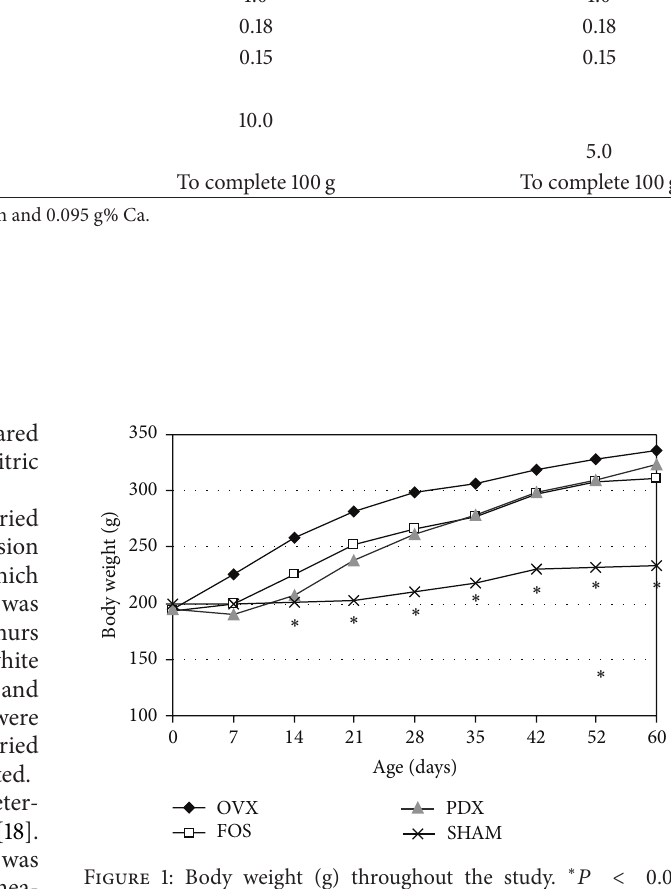
Figure 1: Body weight (g) throughout the study. ∗ 𝑃 < 0.01 versus the other three studied groups. Differences were analyzed by Bonferroni test after